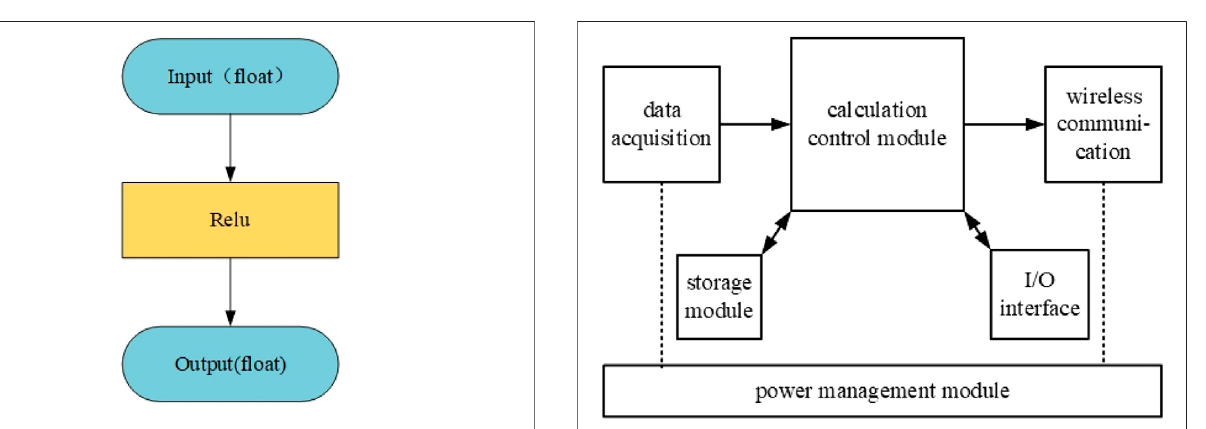
FIGURE 6 | Relu operation before quantization.